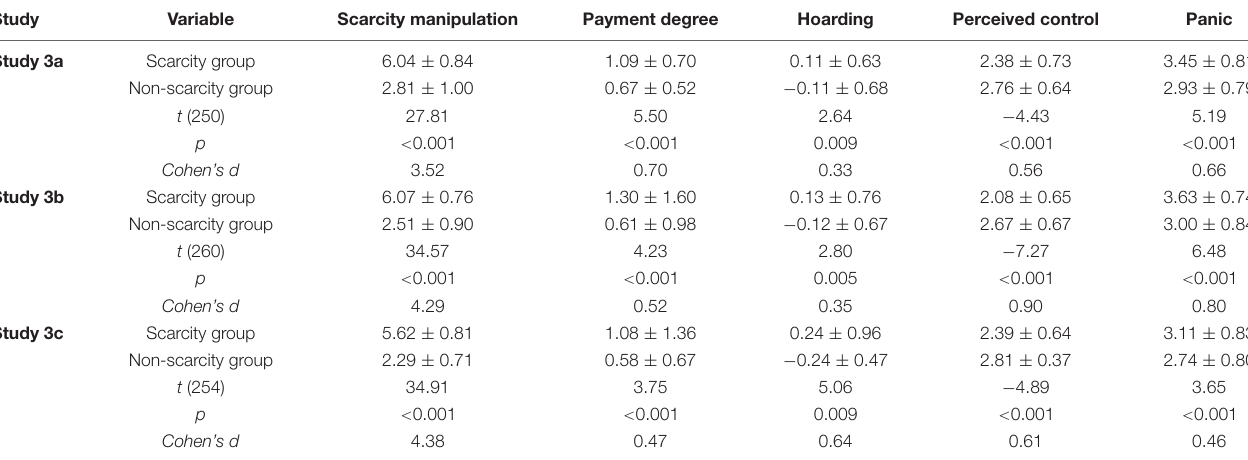
TABLE 4 | Descriptive statistics of key variables and the effect sizes of scarcity manipulation in study